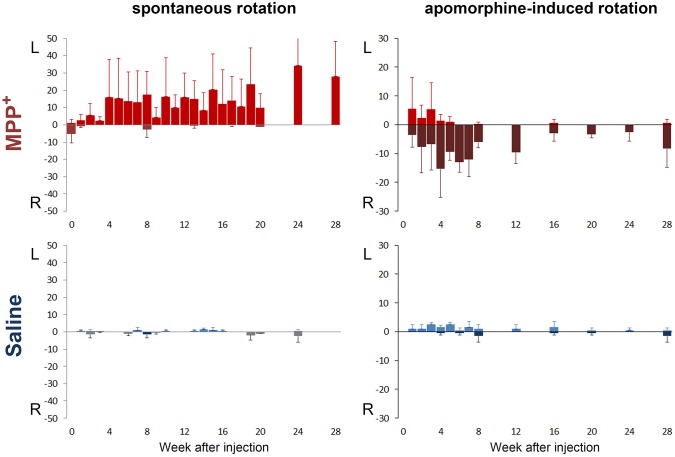
Lasting rotation behavior in the monkeys.Four panels show the spontaneous and APO-induced rotation counts in MPP+ (red, N = 3) and control (blue, N = 2) monkeys over 28 weeks. The ordinate represents the rotation direction (positive and lighter bars for left, negative and darker bars for right) and the number of rotations each week. Spontaneous rotations were counted during weeks 0–20, 24 and 28. APO-induced rotations were counted during weeks 1–8, 12, 16, 20, 24 and 28, respectively. The MPP+ monkeys developed a stable spontaneous left rotation behavior and were reversed to the right by APO, while control monkeys only displayed a few casual rotations throughout the 28 week period. There was a significant interaction effect of APO×MPP+ on APO-induced right rotation [Greenhouse-Geisser (GG), P = 0.039]. No significant effect of week was revealed (multivariate, Pillai’s Trace, P = 0.781; univariate, left, GG, P = 0.487; univariate, right, GG, P = 0.477) which indicated stable rotational behaviors for at least 28 weeks.